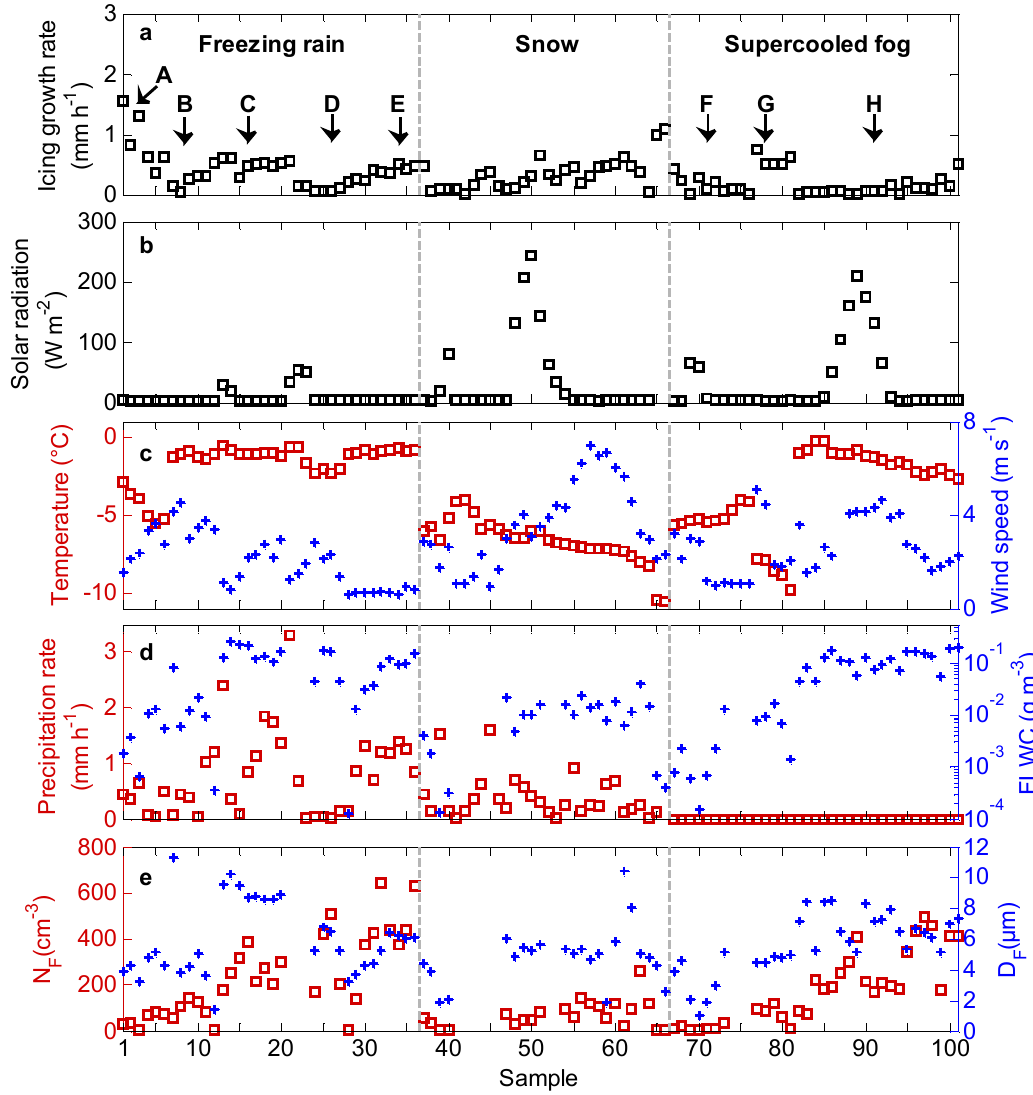
Figure 5. Distributions of ( a ) icing growth rate, ( b ) solar radiation, ( c ) air temperature and wind speed, ( d ) precipitation rate and fog liquid water content (FLWC), and ( e ) fog droplet number concentration ( N F ) and fog droplet mean diameter ( D F ) in freezing rain, snow, and supercooled fog.